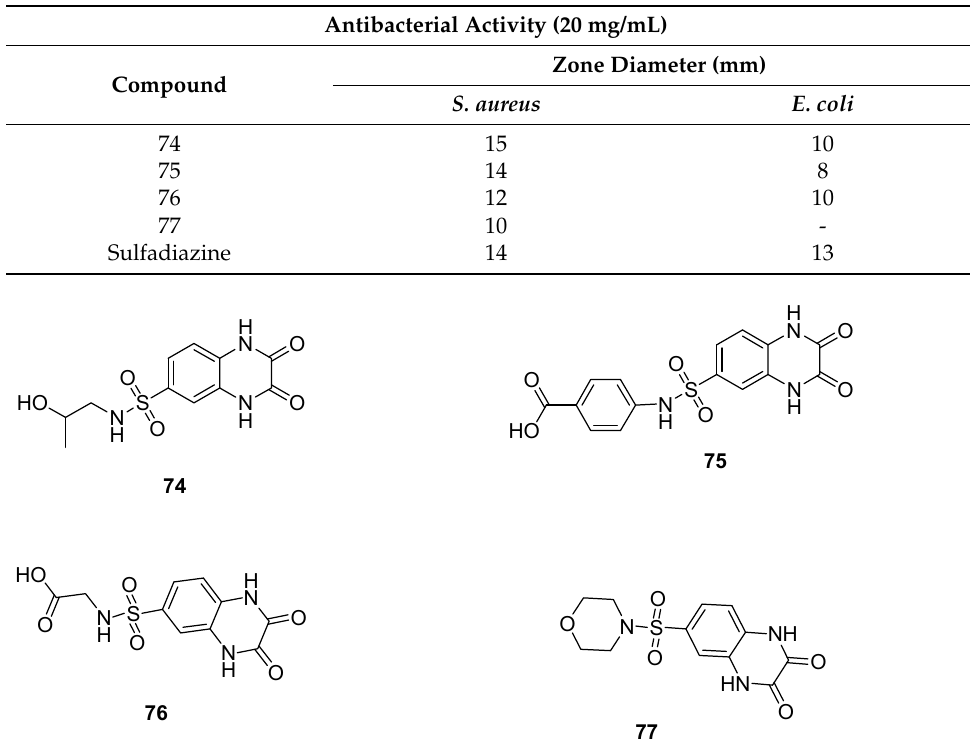
Figure 11. Quinaxoline sulfonamide derivatives 74–77 .